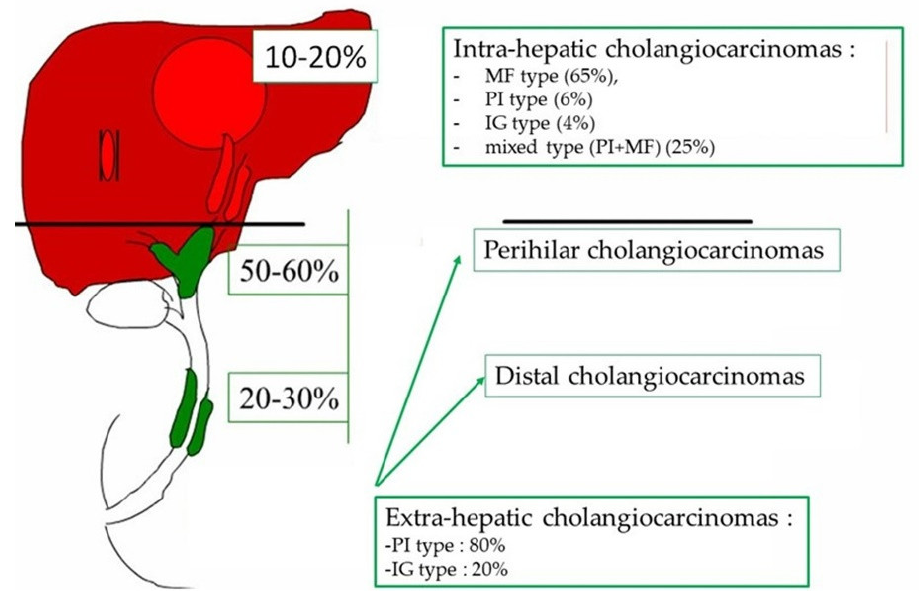
Figure 1. Localization, distribution and frequency of the macroscopic type of cholangiocarcinoma. MF: maa forming, PI: periductal infiltrating, IG: intraductal growth.